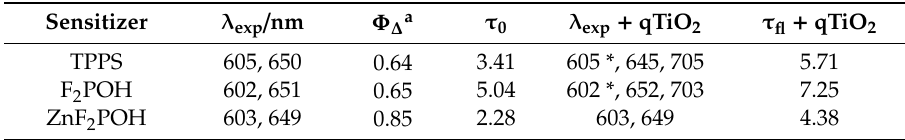
Table 2. Photophysical properties of sulfonyl porphyrin derivatives in the absence and presence of colloidal qTiO 2 ( τ 0 is the lifetime in the absence of colloidal qTiO 2 , τ fl is the lifetime in the presence of colloidal qTiO 2 ).